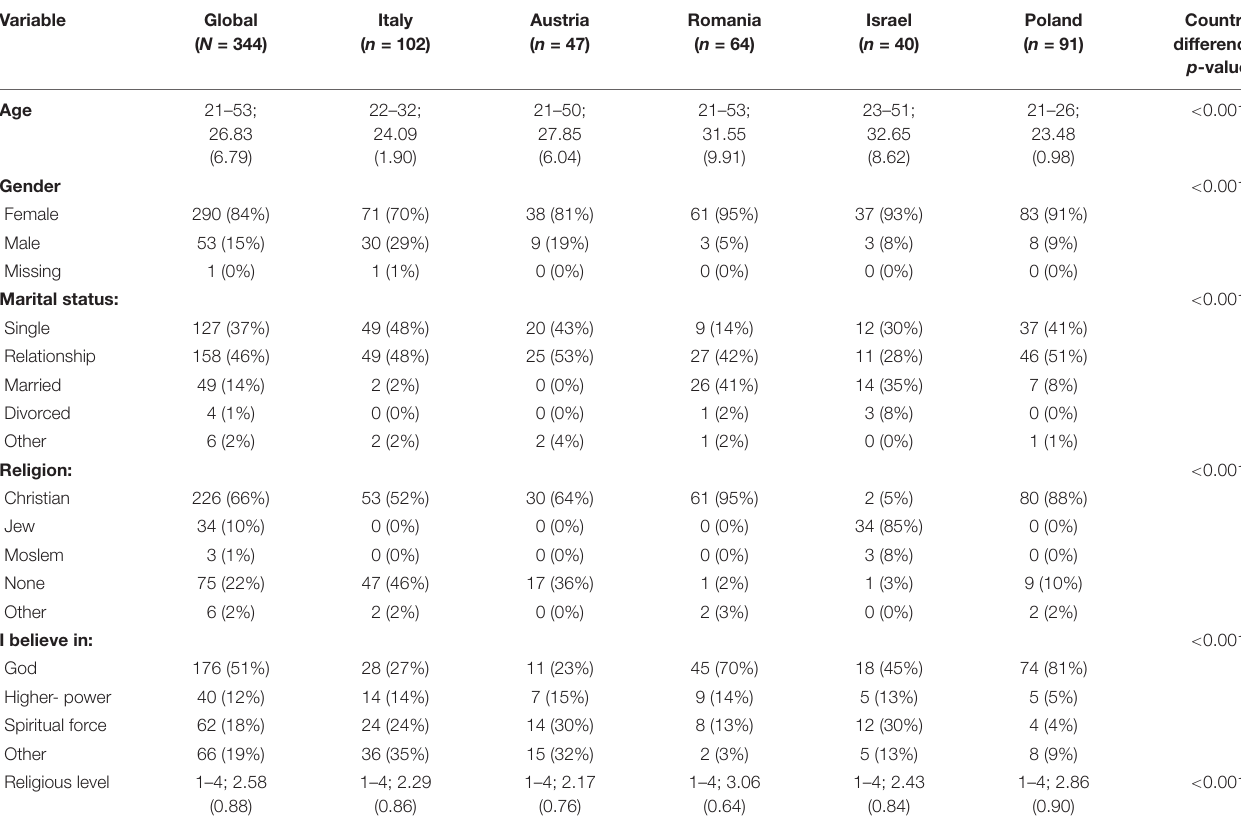
TABLE 1 | Descriptive statistics for demographic variables and differences between countries for each variable.